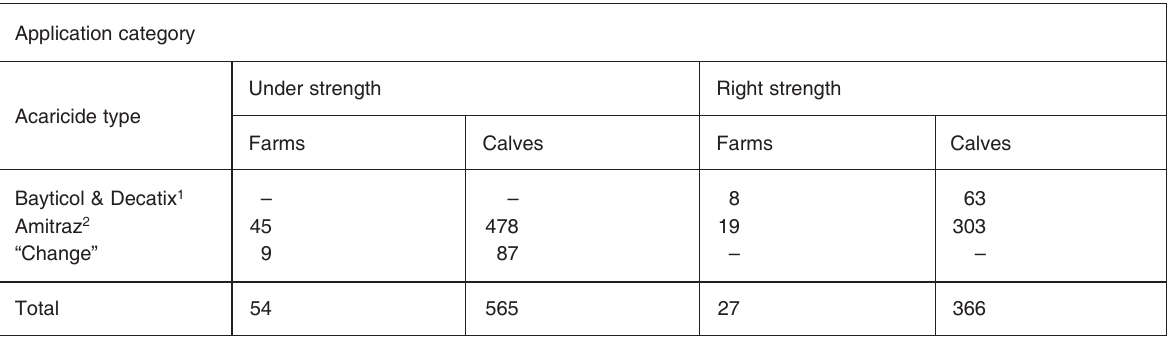
TABLE 1 Farms and calf distribution in the Ankole ranching scheme with respect to tick control practices and the type of acaricide used